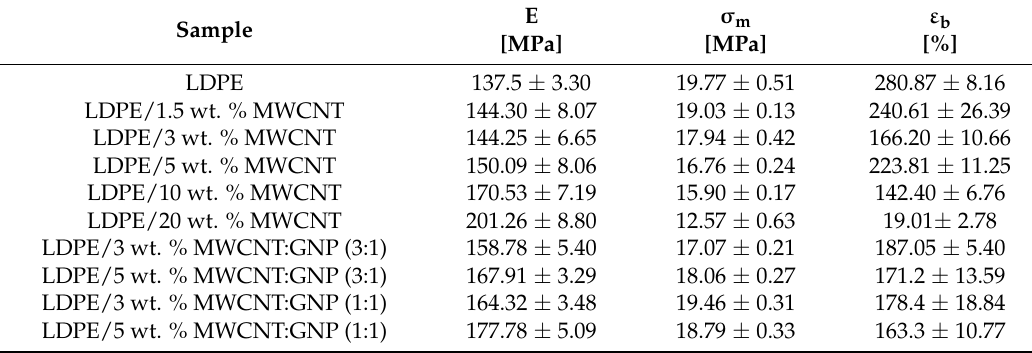
Table 3. Mechanical properties of neat LDPE and LDPE-based